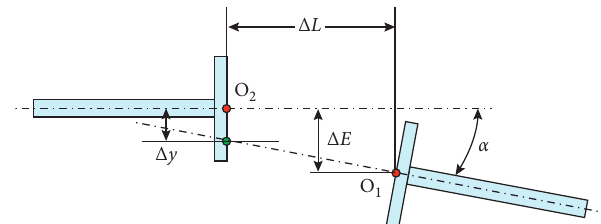
Figure 3: Model of misalignment modeling between Subsystems 1 and